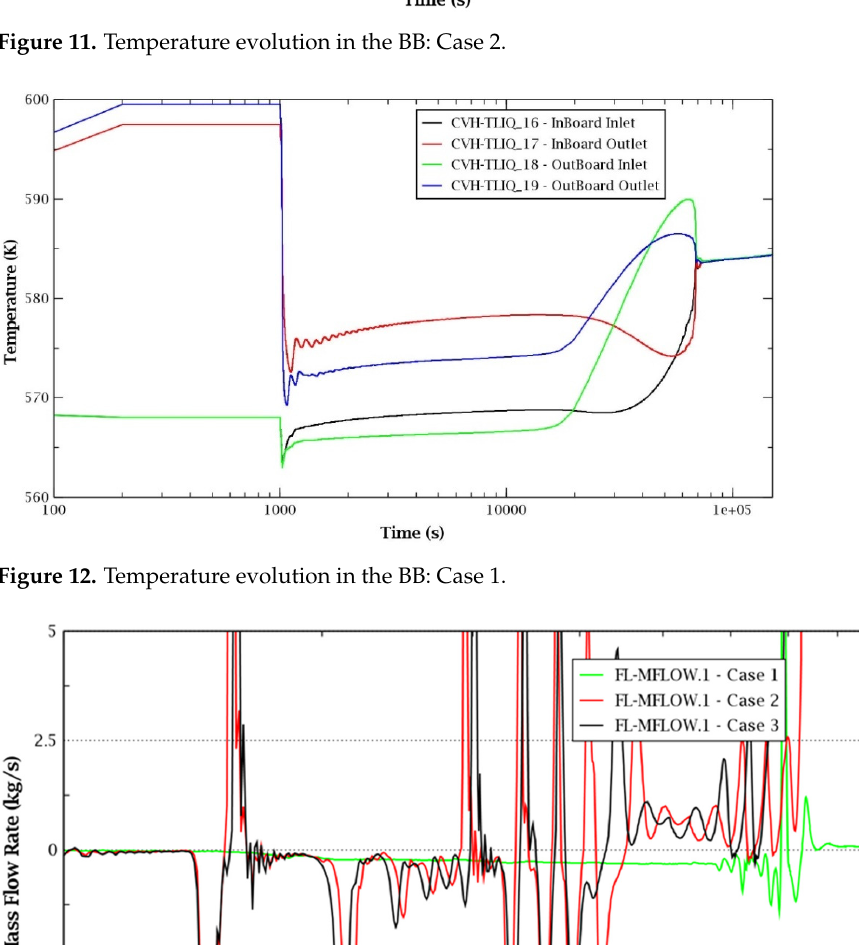
Figure 11. Temperature evolution in the BB: Case 2.